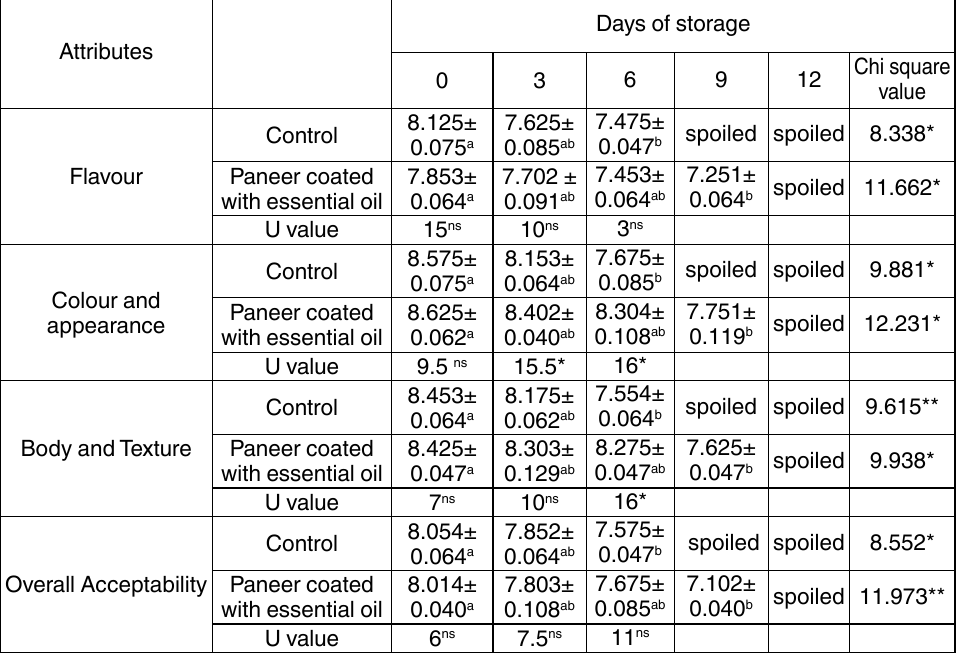
table 3. Effect of refrigerated storage (7 ± 1°C) on the sensory quality of paneer coated with essential